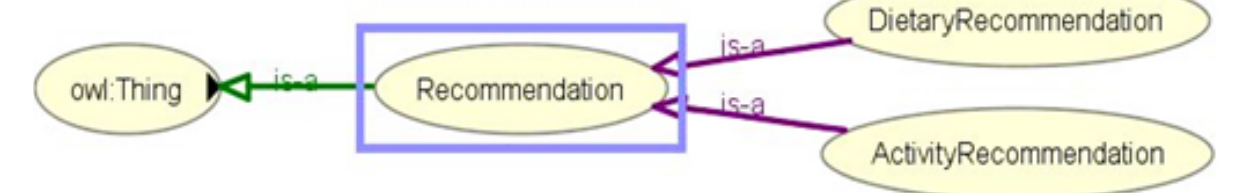
Figure 1. Asserted hierarchy for lifestyle recommendation for obesity